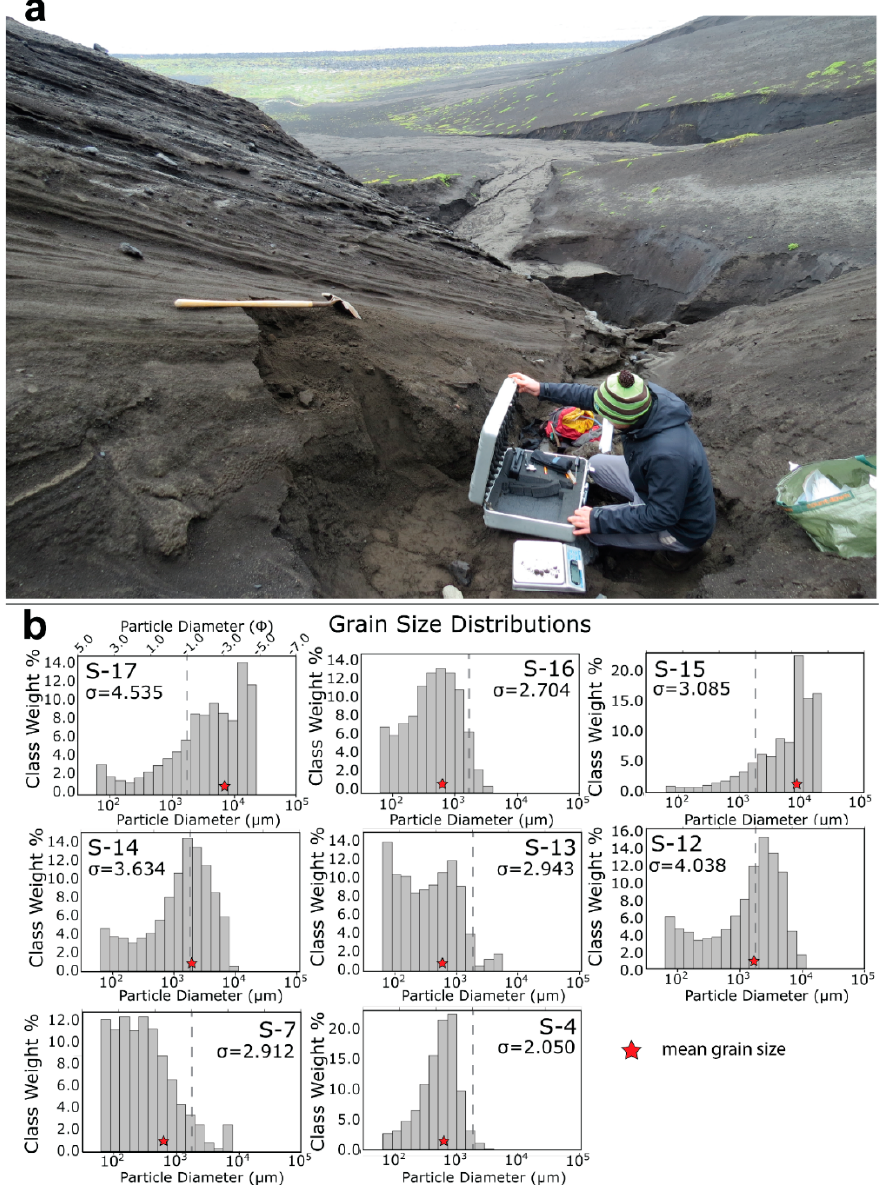
Figure 2. ( a ) Field photo showing the outcrop where the lapilli analysed for this study (SY sample set) were sampled; and ( b ) grain size distributions for the samples (S sample set) collected in 2014 (see Figure 1 for exact sample locations). The dashed lines represent the different fields for ash ( left side ) and lapilli ( right side ), following the classification of [57].